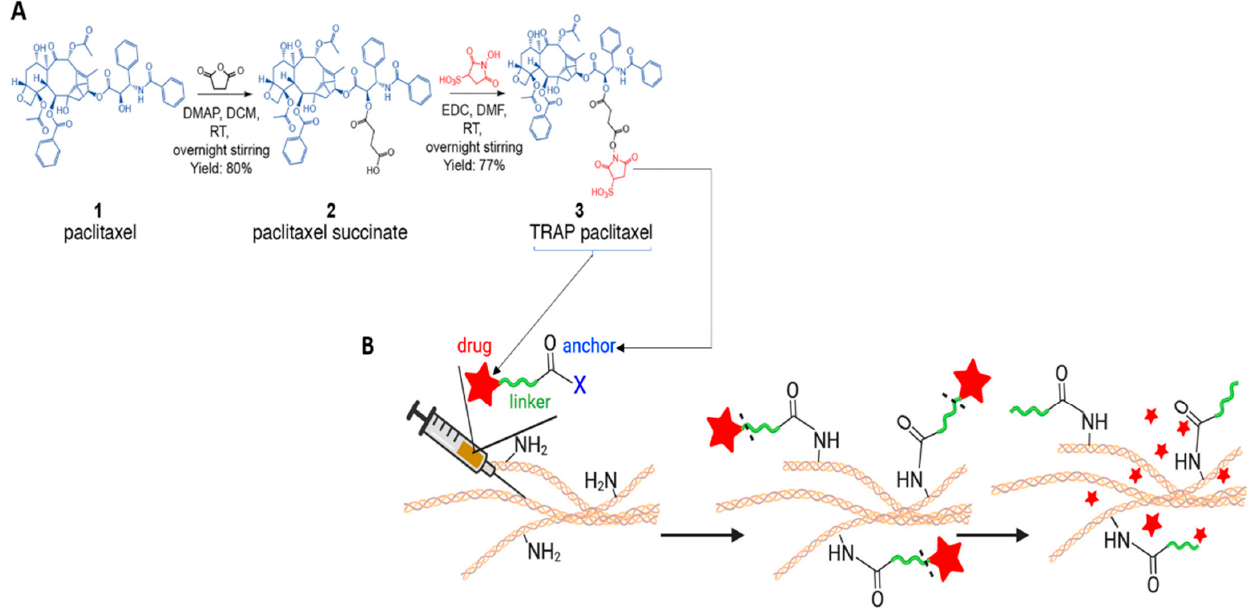
Figure 4. Graphical illustration of PTX-TRAP depots’ conceptual framework. ( A ) Synthesis scheme of TRAP PTX: PTX was dissolved in DCM and reacted with succinic anhydride in the presence of DMAP at room temperature to yield PTX succinic acid (PTX-SA). Purified PTX-SA was then reacted with EDC and sNHS in DMF at room temperature, yielding PTX-sNHS conjugate. ( B ) Following injection, PTX-sNHS conjugate reacted with the amines group on ECM, attaching PTX to the tumour tissues. After the linker moiety dissolved, PTX was released intratumorally. Reprinted and modified with permission from Pandit et al. [106]. 2022, Elsevier. Table 2. Injectable DDSs for localised delivery to pancreatic tumours from 2012–2022. Incorporative Drugs Type Polymer Production